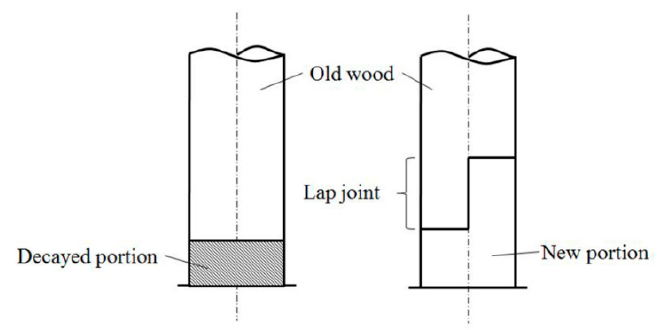
Figure 1. Schematic diagram of the spliced method for a timber column.